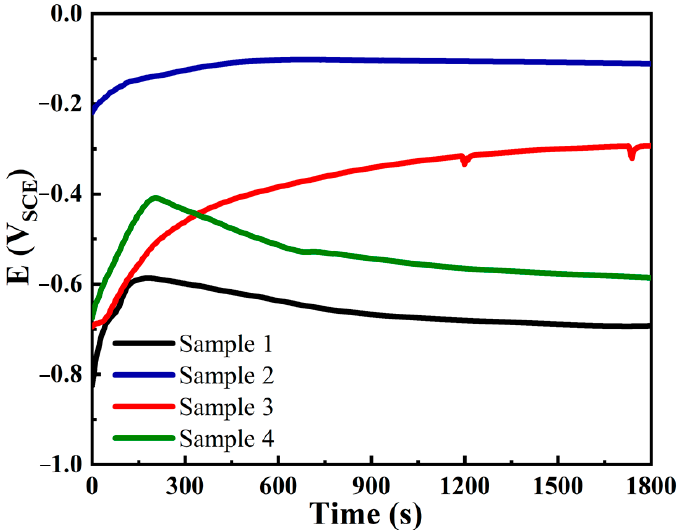
Figure 6. Evolution of OCP evolution of samples with immersion time in 3.5% NaCl solution.